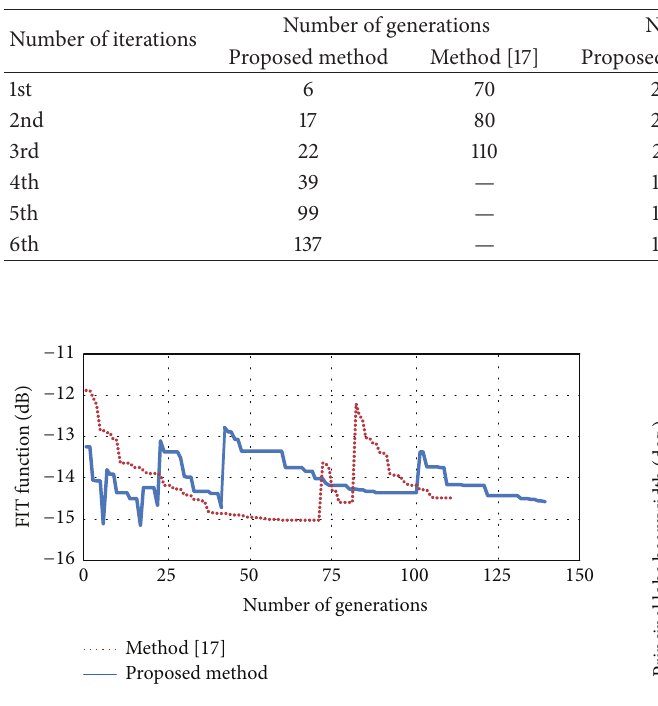
Figure 6: The performance comparison of computation complexity in terms of number of fitness functions.